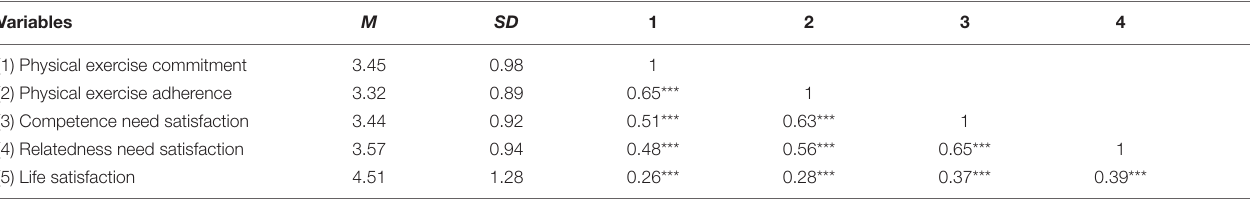
TABLE 1 | The results of descriptive statistics and correlation analysis.